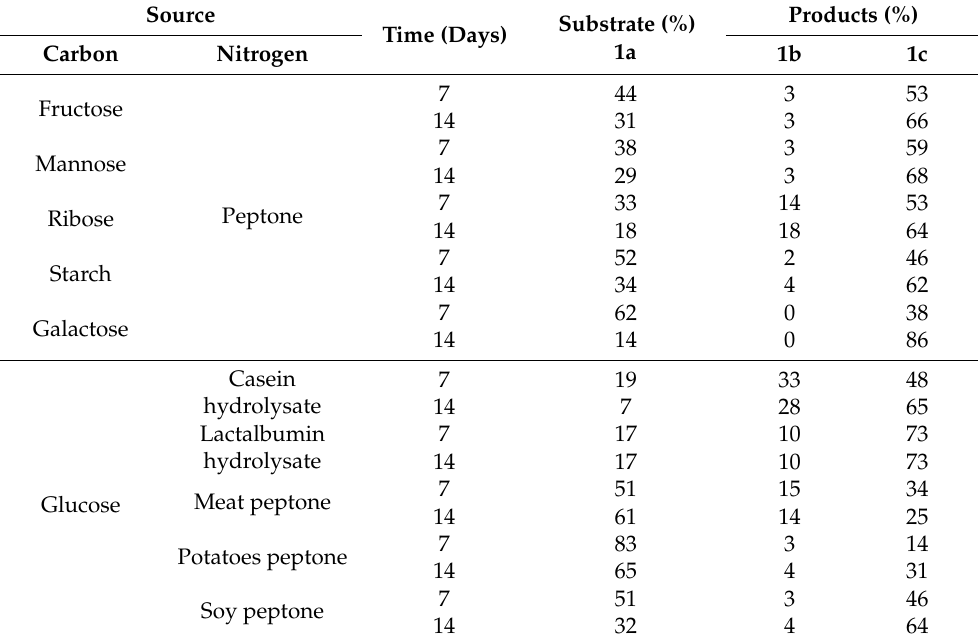
Table 2. Biotransformation of isosafrole ( 1a ) by the Trametes versicolor AM536 strain in various carbon and nitrogen